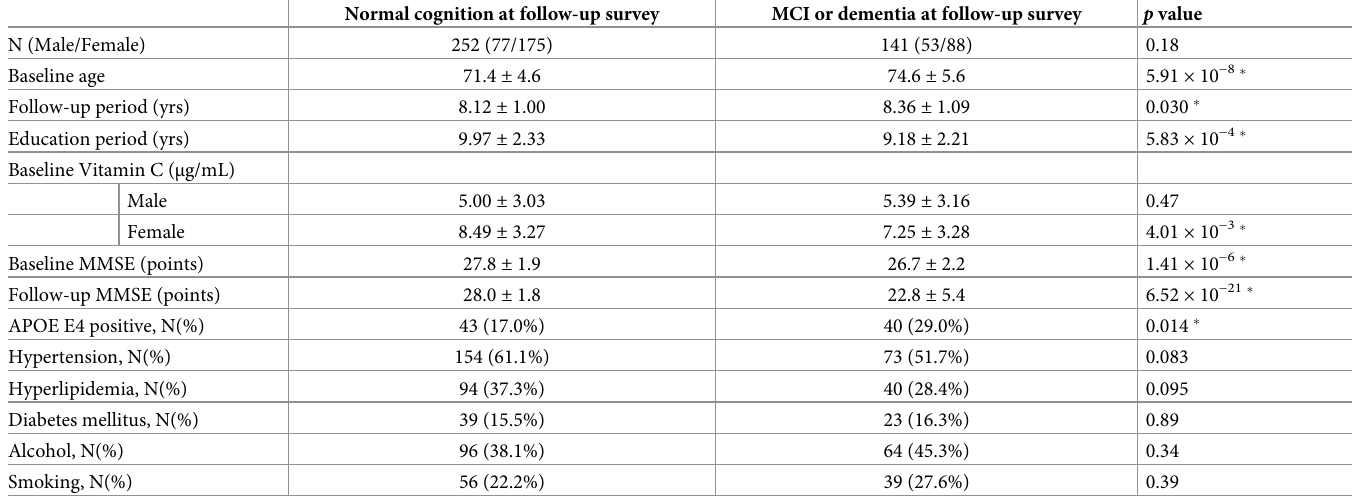
Table 1. Characteristics of the participants with normal cognition (n = 393) at baseline (2006–2008) who presented with normal cognition (n = 252) or MCI/demen- tia (n = 141) in the follow-up survey (2014–2016). Normal cognition at follow-up